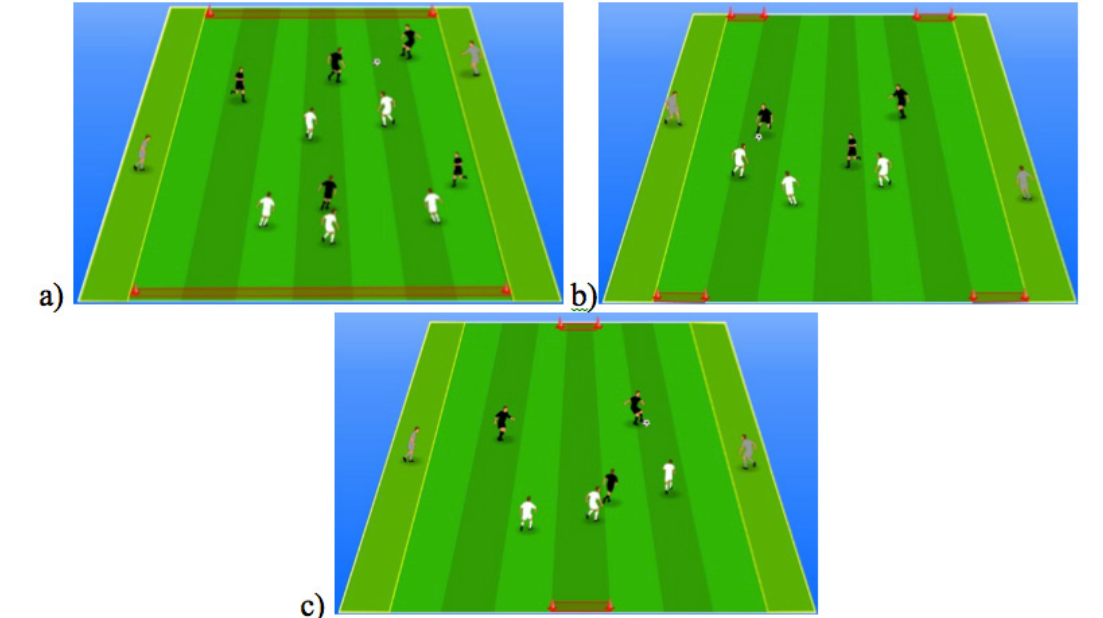
Figure 1. Task conditions: a) task 1; b) task 2; and c) task